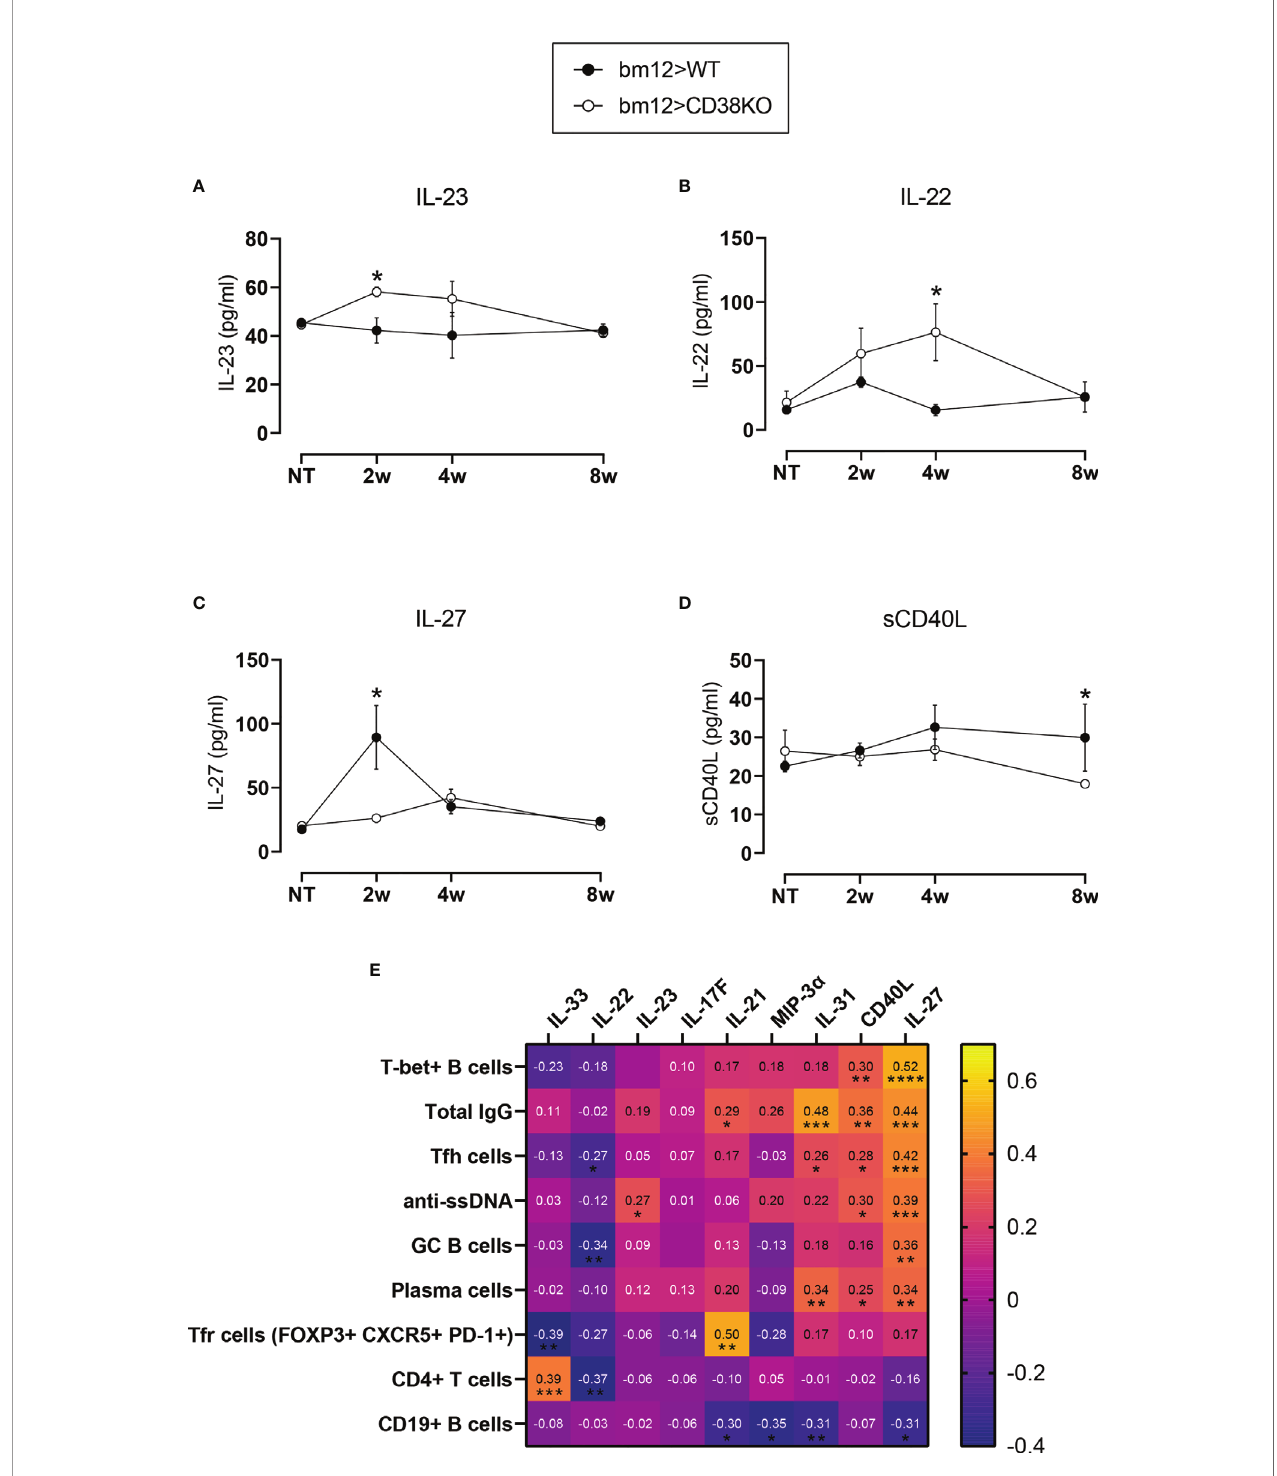
FIGURE 7 | Abnormal cytokine serum levels in Cd38 − / − cGVHD mice. (A) IL-23. (B) IL-22. (C) IL-27. (D) sCD40L. In panels (A – D) WT mice (closed circles) and Cd38 − / − mice (open circles). The symbols are the mean values and the vertical bars represent ± SEM. P -values are shown for Welch ’ s t -test. The results are cumulative data from two to three different experiments per time point and mouse type, each with three to fi ve mice per experiment. (E) Matrix showing Spearman ’ s r correlation values between cytokines serum levels (horizontal) and the frequencies of the T- and B-cell subsets analyzed + anti-ssDNA and total IgG. Asterisks below r numbers denote statistical signi fi cance, which could be positive correlation (no sign) or negative correlation ( − ). * P <